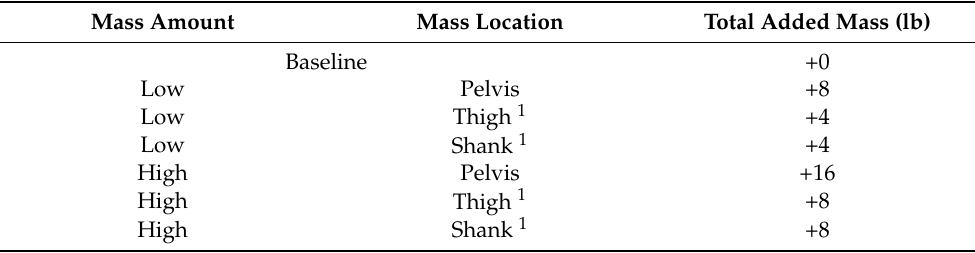
Table 2. The seven experimental conditions included a Baseline condition with no added mass and six added mass conditions varying Mass Amount and Mass Location. Mass Amount Mass Location Total Added Mass (lb) Baseline +0 Low Pelvis +8 Low Thigh 1 +4 Low Shank 1 +4 High Pelvis +16 High Thigh 1 +8 High Shank 1